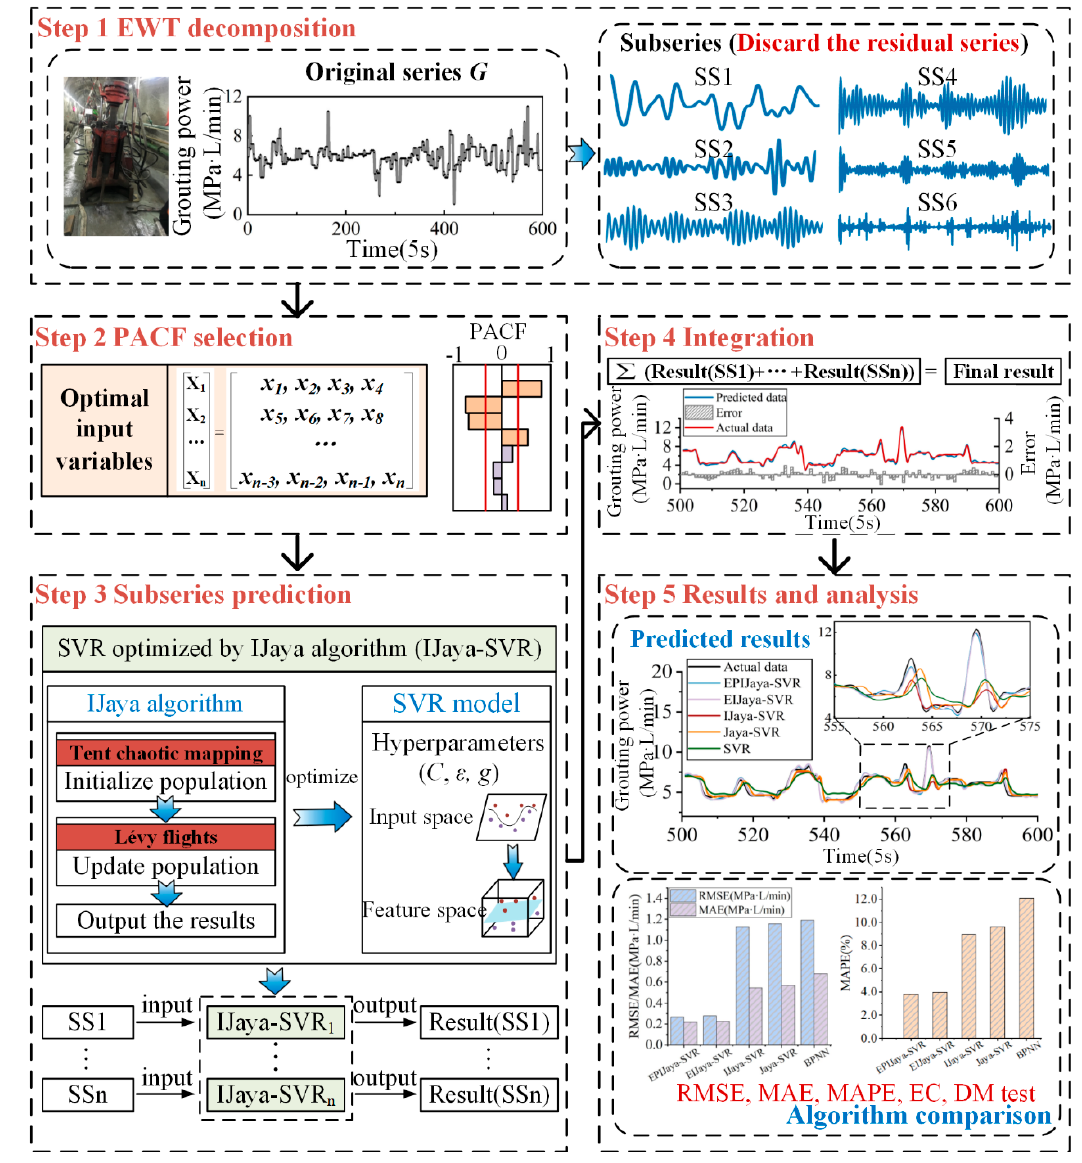
Figure 2. Research framework.